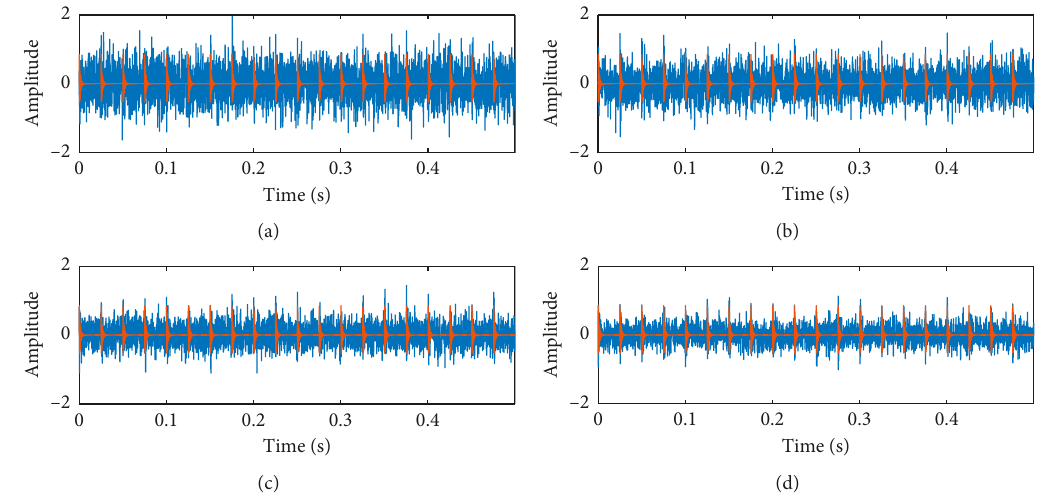
Figure 2: The periodic impact signal with different SNRs: (a) − 12dB; (b) − 10dB; (c) − 8dB; (d) − 6 dB.